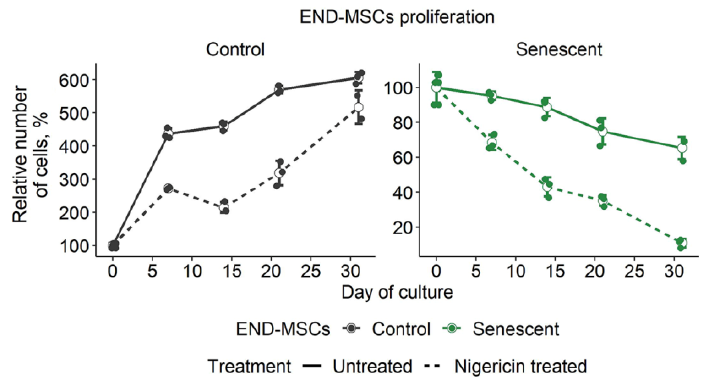
Figure 7. Repeated treatments with nigericin at low doses effectively induced senolysis in senescent END-MSCs and preserved the proliferation of control cells. Control and senescent END-MSCs were treated with 1 μM nigericin for 1 h every 7 days and was observed in culture for 30 days. Values presented are mean ± s.d.